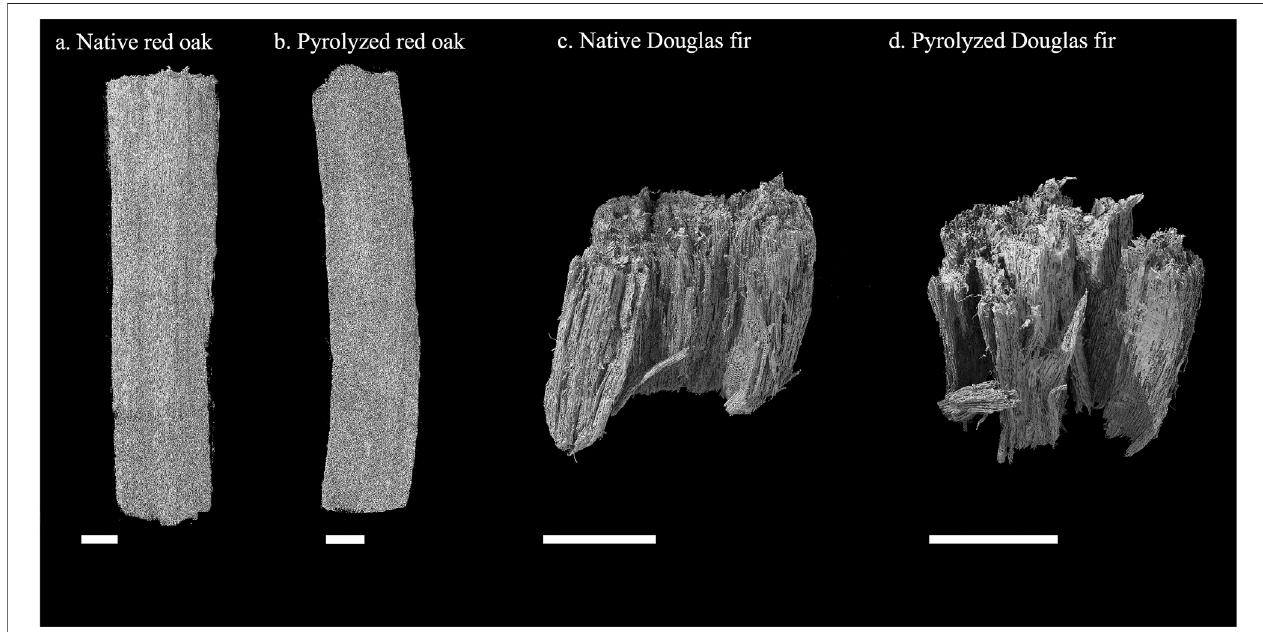
FIGURE 2 | Full particle reconstructions of each sample. (A) Native red oak, (B) Pyrolyzed red oak, (C) Native Douglas fi r (D) Pyrolyzed Douglas fi r. All scale bars indicate 1 mm length.